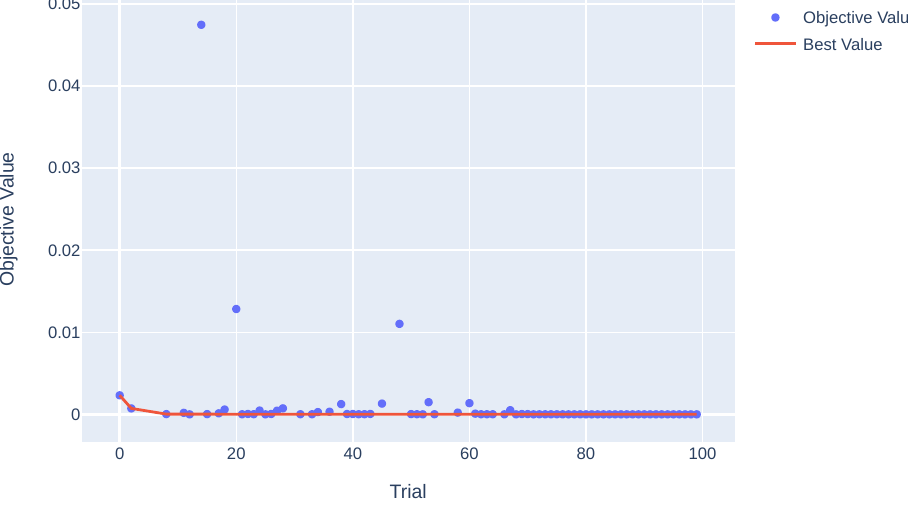
Figure 5. MSE along the optimization